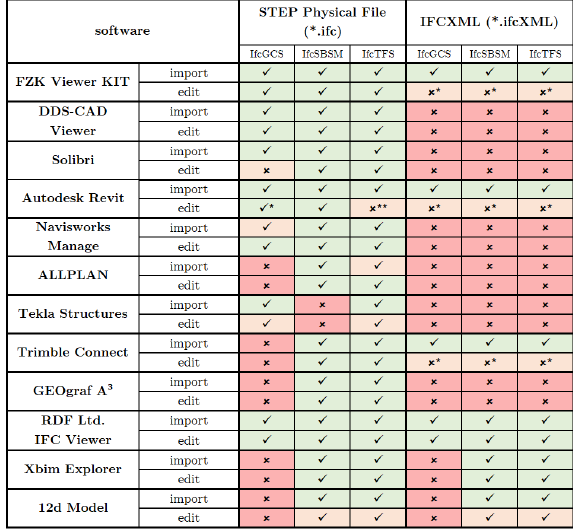
Figure 8. Overview of the test results. The different BIM viewers, BIM authoring systems and BIM collaboration platforms handle the exported geometry types